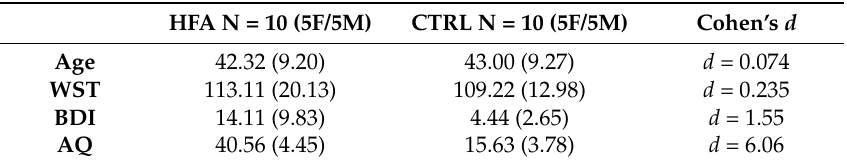
Table 1. Demographic and neuropsychological